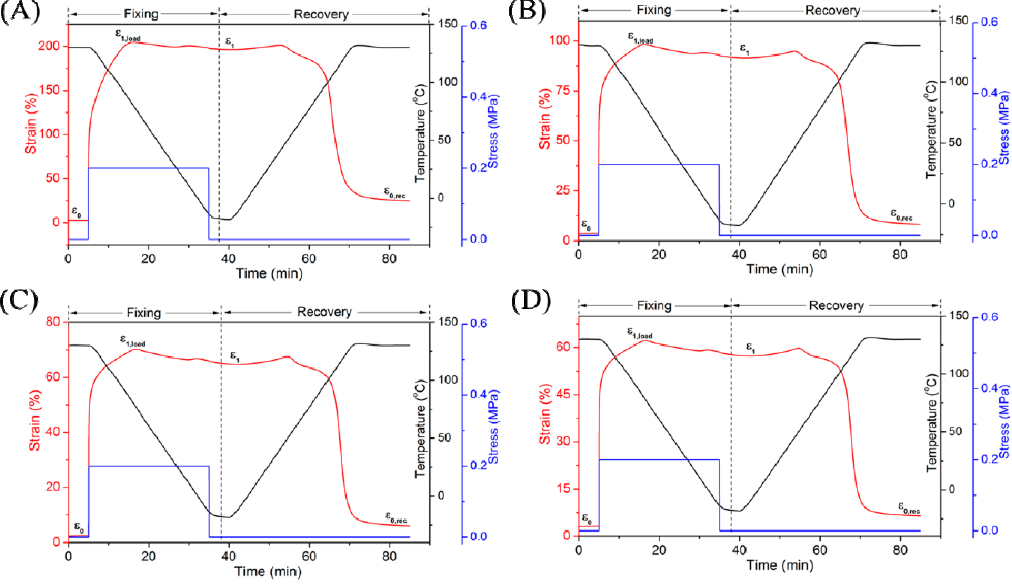
Figure 2. E ff ect of CB dosage on shape memory properties of TPI / LDPE blends. Figure 2. Effect of CB dosage on shape memory properties of TPI/LDPE blends. Table 5. E ff ect of CB dosage on shape memory properties of TPI / LDPE composites. Table 5. Effect of CB dosage on shape memory properties of TPI/LDPE composites.